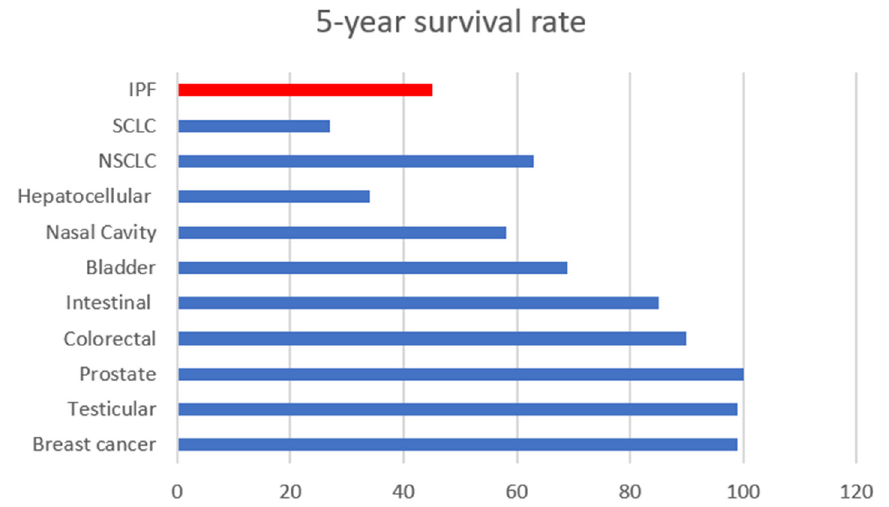
Figure 1. The 5-year survival percentage of idiopathic pulmonary fibrosis (IPF) relative to several types of cancers. The cancer 5-year survival data were retrieved from the American Cancer Society [37] .